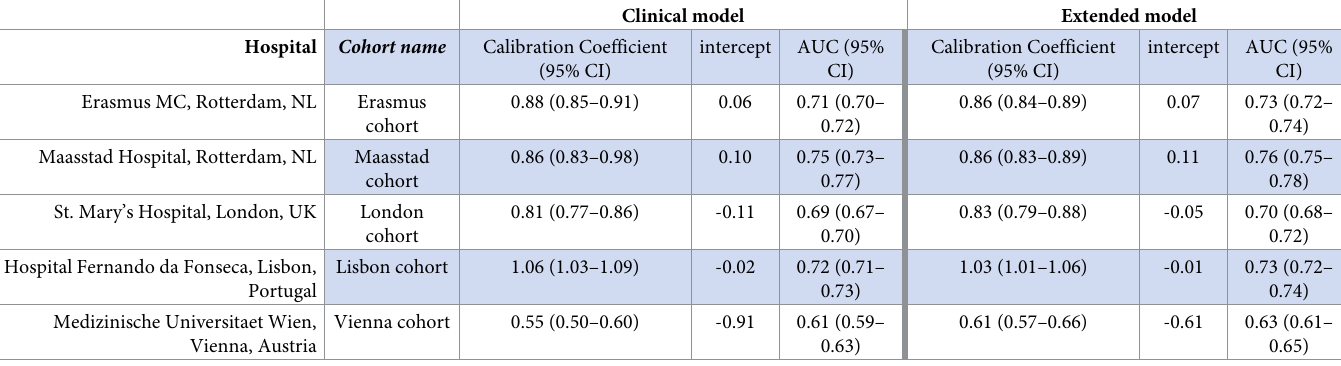
Table 4. Performance of the prediction models in the cross-validation